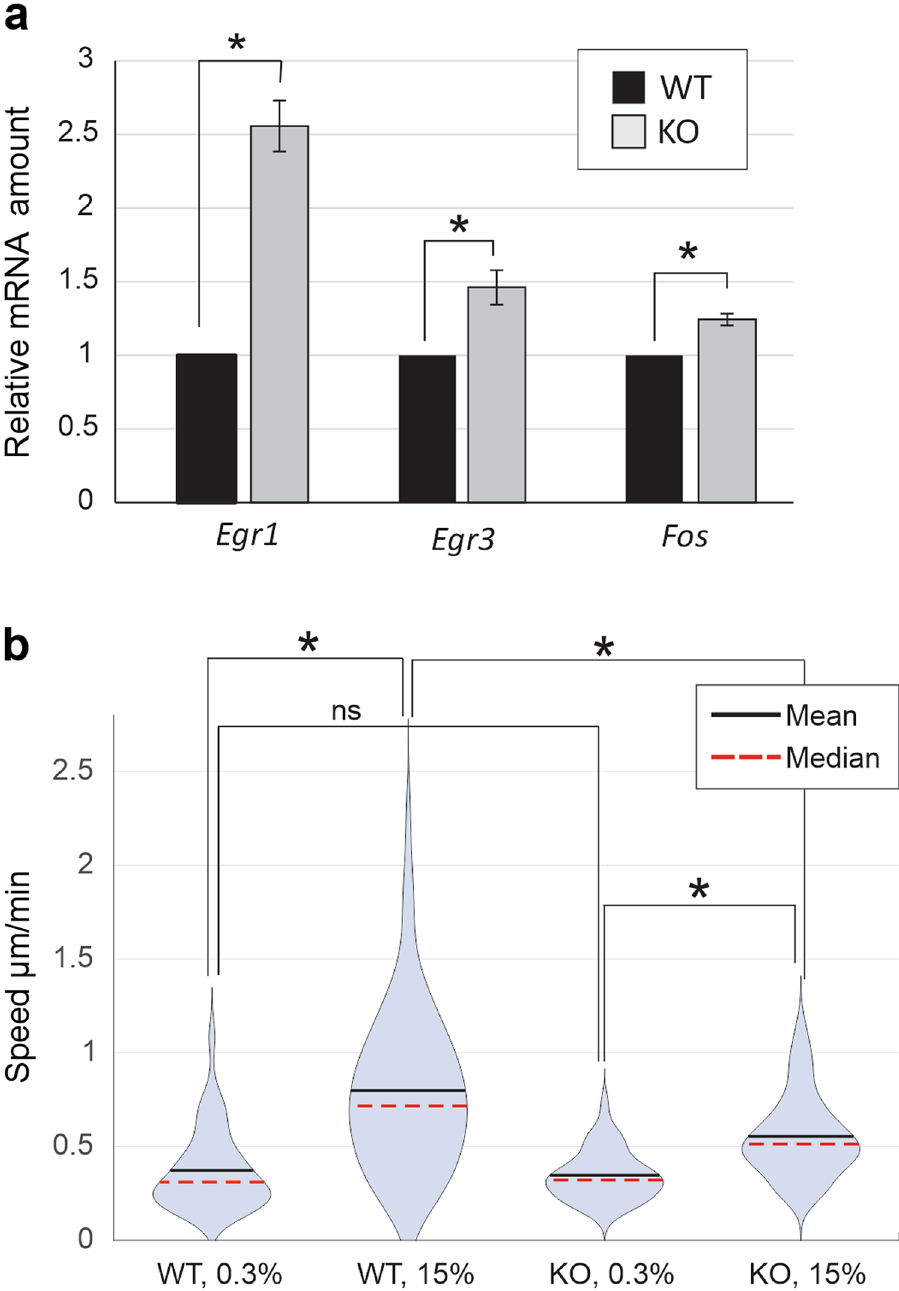
Figure 2. Loss of Lap2α leads to increased expression of TCF/SRF target genes and reduced cell migration. (a) Serum-induced activation of TCF/SRF target genes is increased in Lap2α KO MDFs compared to Lap2α WT MDFs. The data is shown as mean with n = 4, normalized to Lap2α WT cells and error bars are s.e.m. *Statistically significant differences ( P < 0.01) tested by Student’s t -test P -values: WT vs KO for Egr1 1.08 × 10 –4 , WT vs KO for Egr3 2.5 × 10 –3 , WT vs KO for Fos 1.45 × 10 –3 . (b) Single cell tracking assay shows decreased motility of Lap2α KO MDFs compared to Lap2α WT MDFs in serum-stimulated conditions. Data is presented as violin plots showing distribution of average speeds for each condition with mean and median indicated. Total number of tracks: N = 89 WT 0.3%, N = 89 WT 15%; N = 107 KO 0.3%, N = 106 KO 15%. Mean values and s.t.d.: WT 0.3% 0.369 ± 0.216; WT 15% 0.783 ± 0.4; KO 0.3% 0.352 ± 0.14; KO 15% 0.556 ± 0.22. Statistically significant differences (*) tested by Kolmogorov–Smirnov test with 0.05 significance level. ns., not significant. D-values: WT 0.3% vs WT 15% 0.614; KO 0.3% vs KO 15% 0.489; WT 15% vs KO 15% 0.383; WT 0.3% vs KO 0.3% 0.174